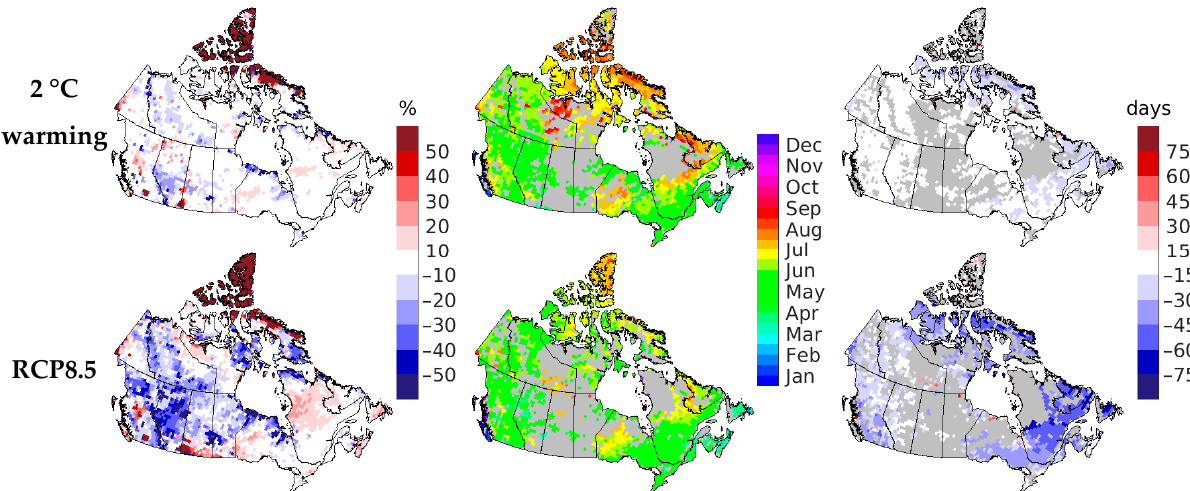
Figure 5. Projected changes to median annual maximum streamflow with respect to 1981–2010 (first column), projected average date of occurrence of annual maximum streamflow (second column), and its projected changes with respect to 1981–2010 (third column). Projections for both 2 °C warming (top row) and RCP8.5 2070–2099 (bottom row) are shown. Grey is used for the date at locations where less than 50% of annual maximum events occur within 30 days of the average date.